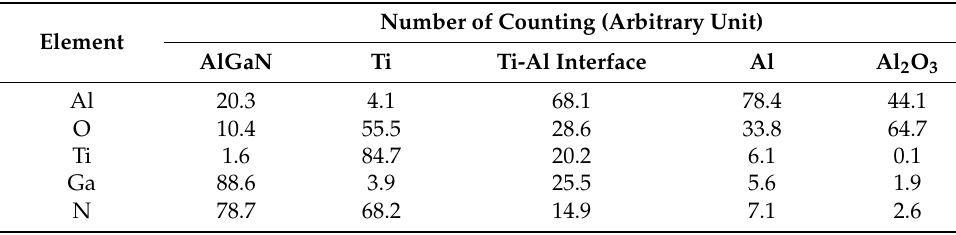
Table 4. The average content of the elements within each layer in area 2.